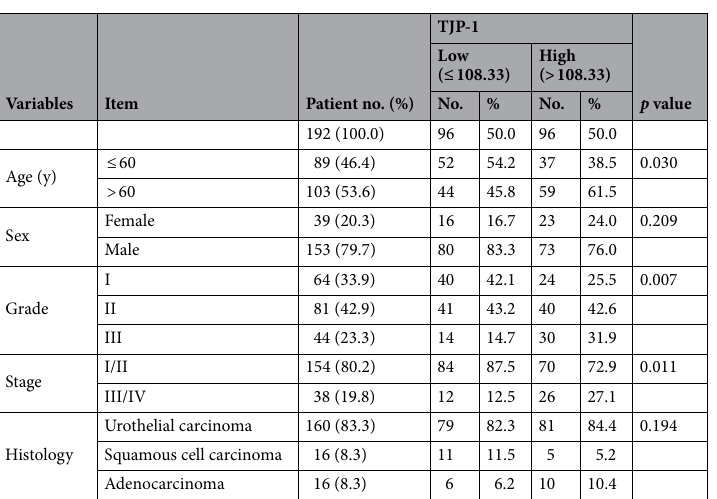
Table 1. Correlation of TJP-1 expression with clinicopathological characteristics in bladder